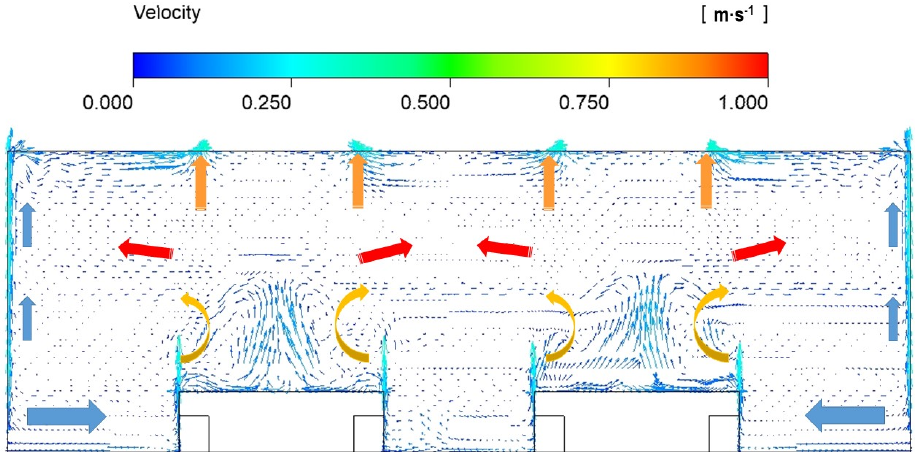
Figure 5. Velocity field in XZ plane at Y = 4.5 m under ACR of 3.